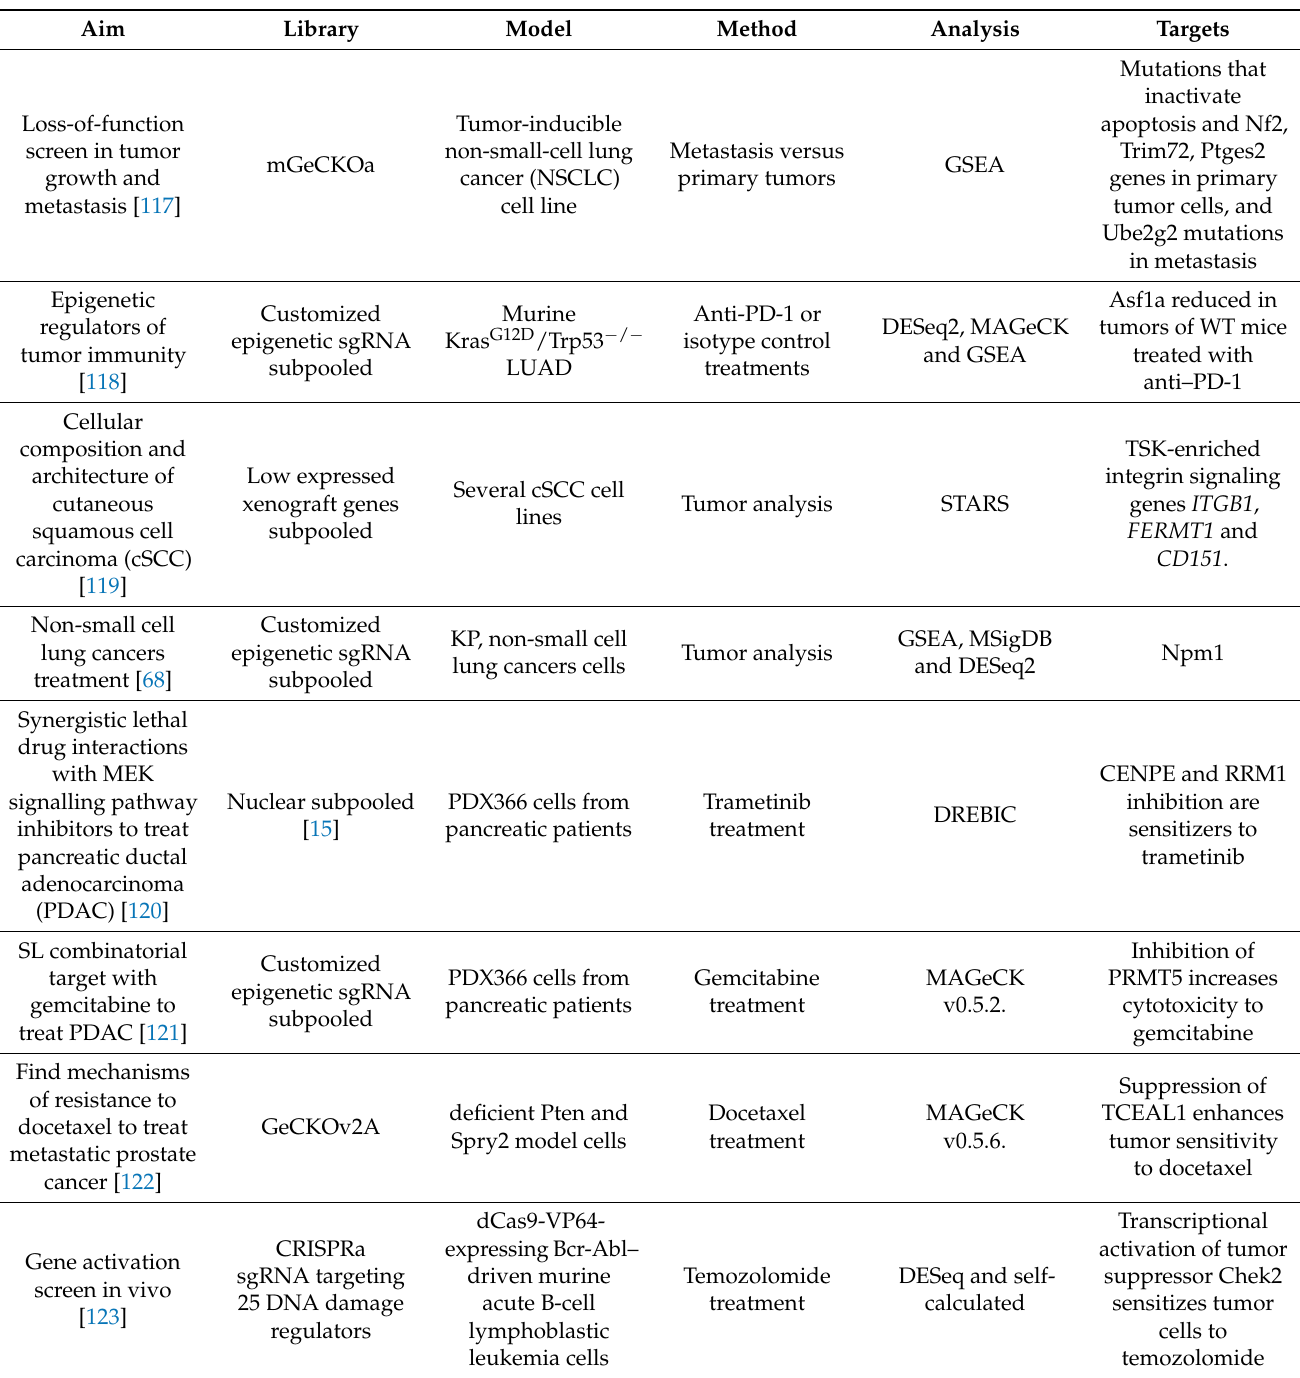
Table 4. In vivo CRISPR